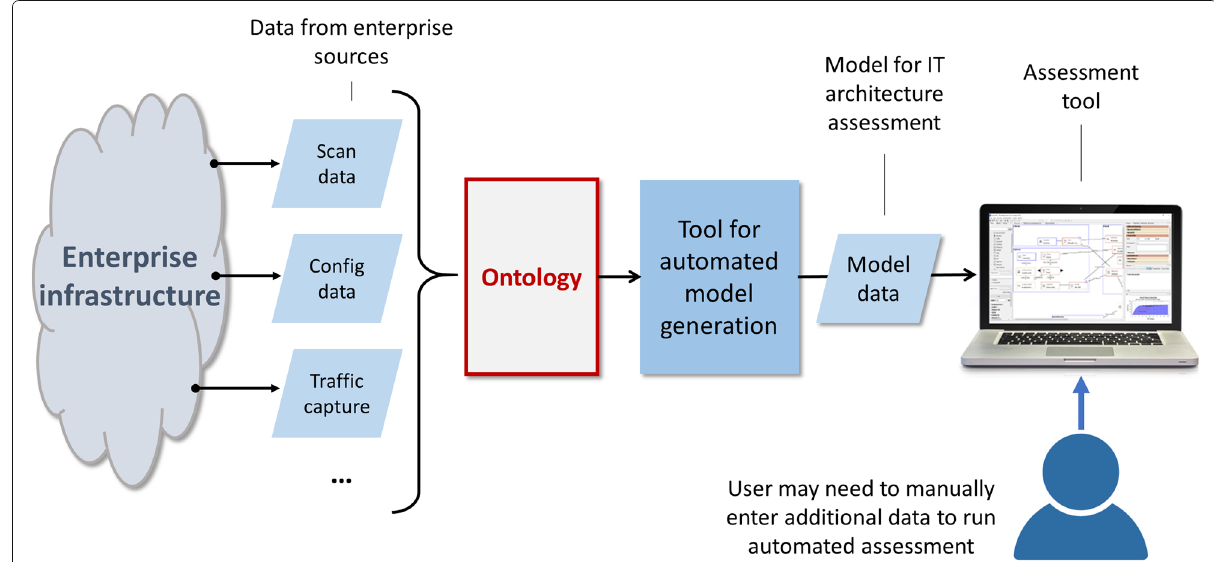
Fig. 1 Data is collected from an enterprise environment, standardized, merged, and finally transformed into a threat